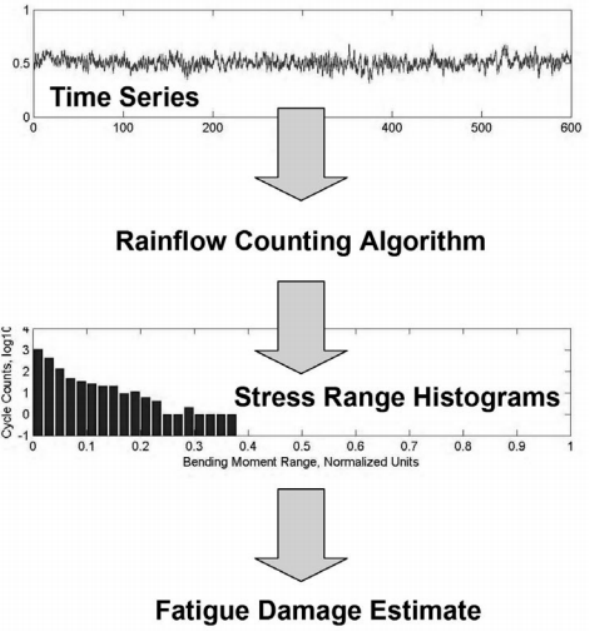
Figure 1. Conventional fatigue load estimation (Ragan and Manuel,